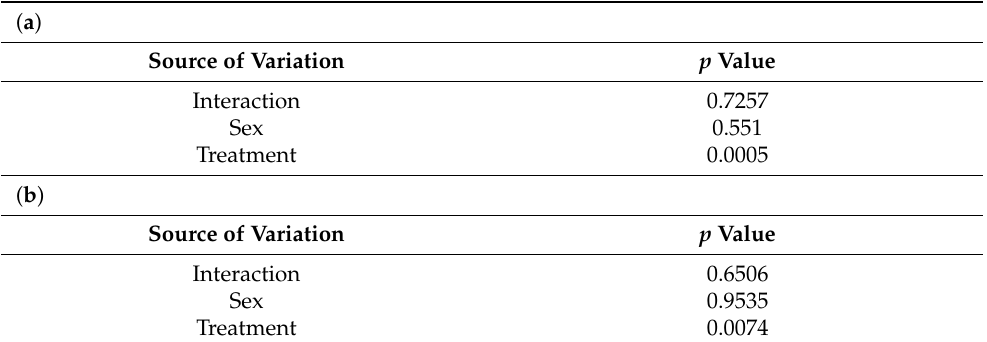
Table 2. ( a ) Statistical table of the individual effects and interactions of rat sex and treatment on cardiac HO-1 concentration. ( b ) Statistical table of the individual effects and interactions of rat sex and treatment on cardiac HO activity.